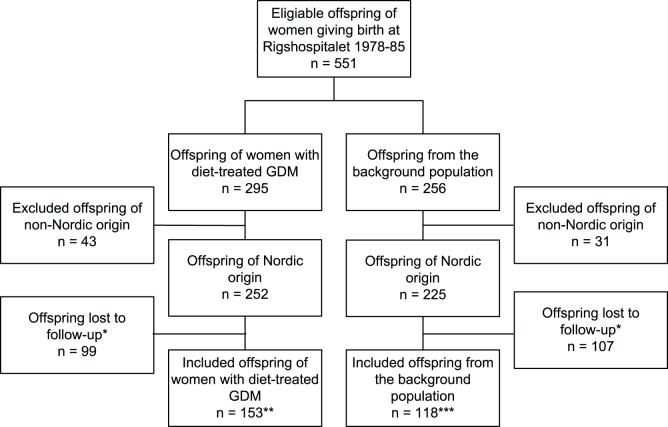
Flow chart describing subjects in the study.GDM: gestational diabetes mellitus *Reasons for lost to follow-up: Offspring of women with diet-treated GDM: 50% did not respond, 26% refused to participate, 9% had emigrated, 6% had died, 4% did not show up and 5% had other reasons. Offspring from the background population: 42% did not respond, 33% refused to participate, 9% had emigrated, 4% had died, 8% did not show up and 4% had other reasons. **Included offspring of women with GDM: 61% (153/252) of all Nordic offspring, 52% (153/295) of eligible offspring. ***Included offspring of women from the background population: 52% (118/225) of all Nordic offspring, 46% (118/256) of eligible offspring.